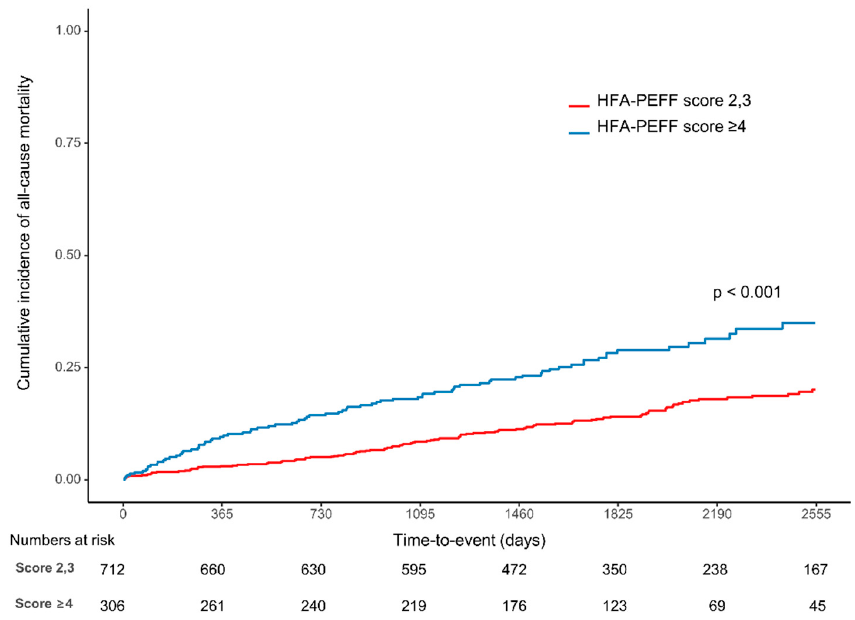
Table 4. Clinical outcomes according to the HFA-PEFF score in patients with AMI suspected of